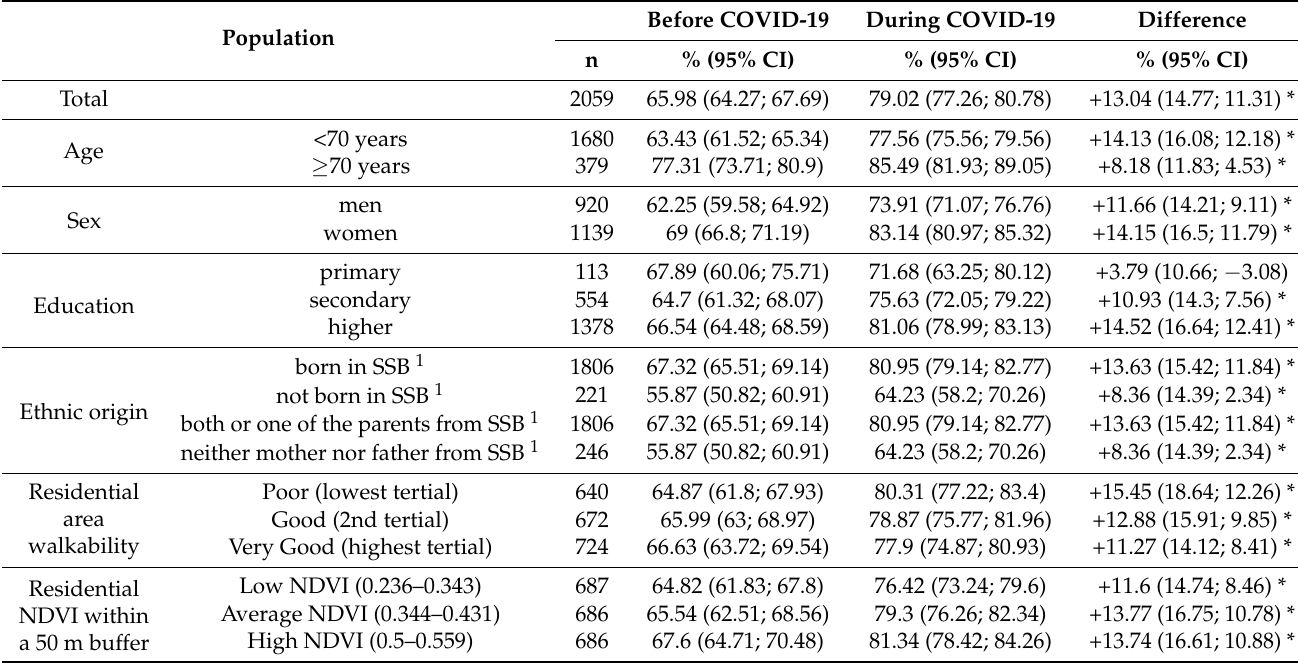
Table 2. The percentage of people that reported that they visit natural areas “often” (* p < 0.05; CI—confidence interval).